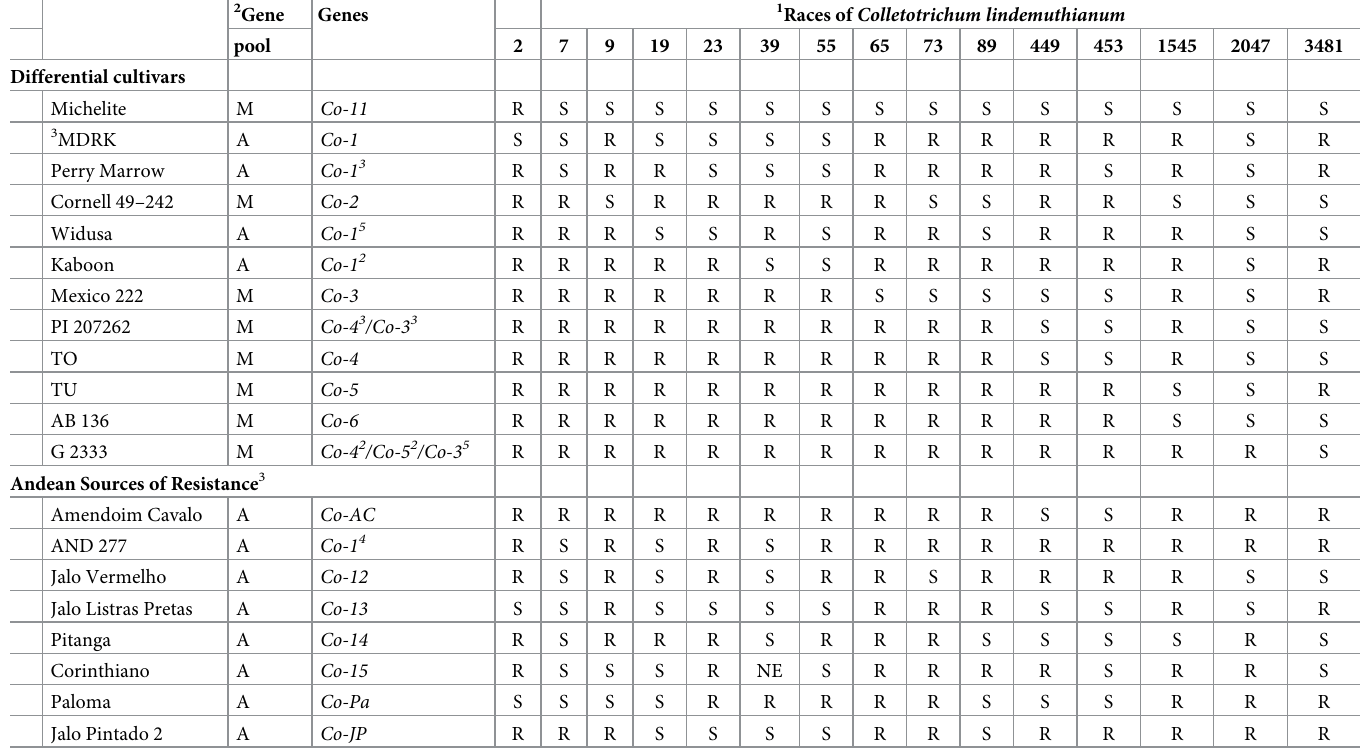
Table 1. Reactions of 12 differential cultivars and of eight Andean common bean cultivars to Mesoamerican and Andean races of Colletotrichum lindemuthianum .